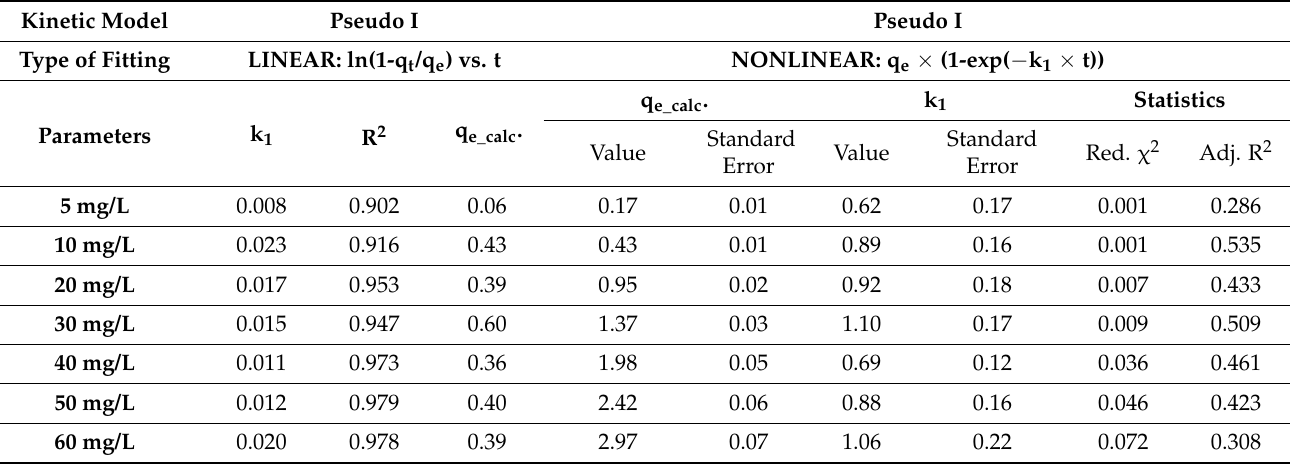
Table 3. Calculated parameters for linear and nonlinear kinetic models for RR dye adsorption